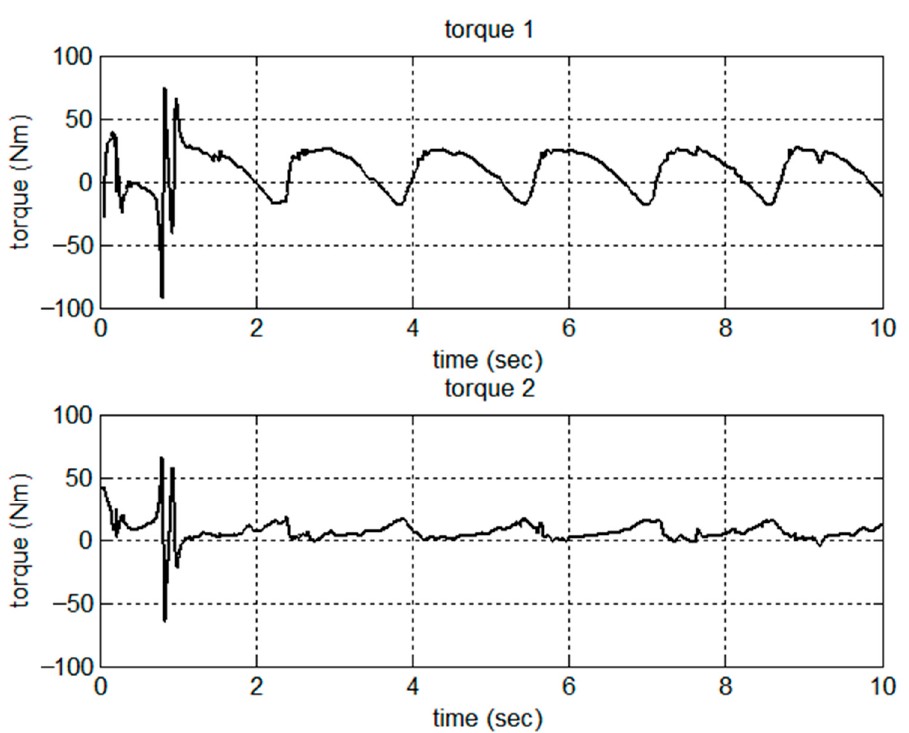
Figure 9. Control torques.